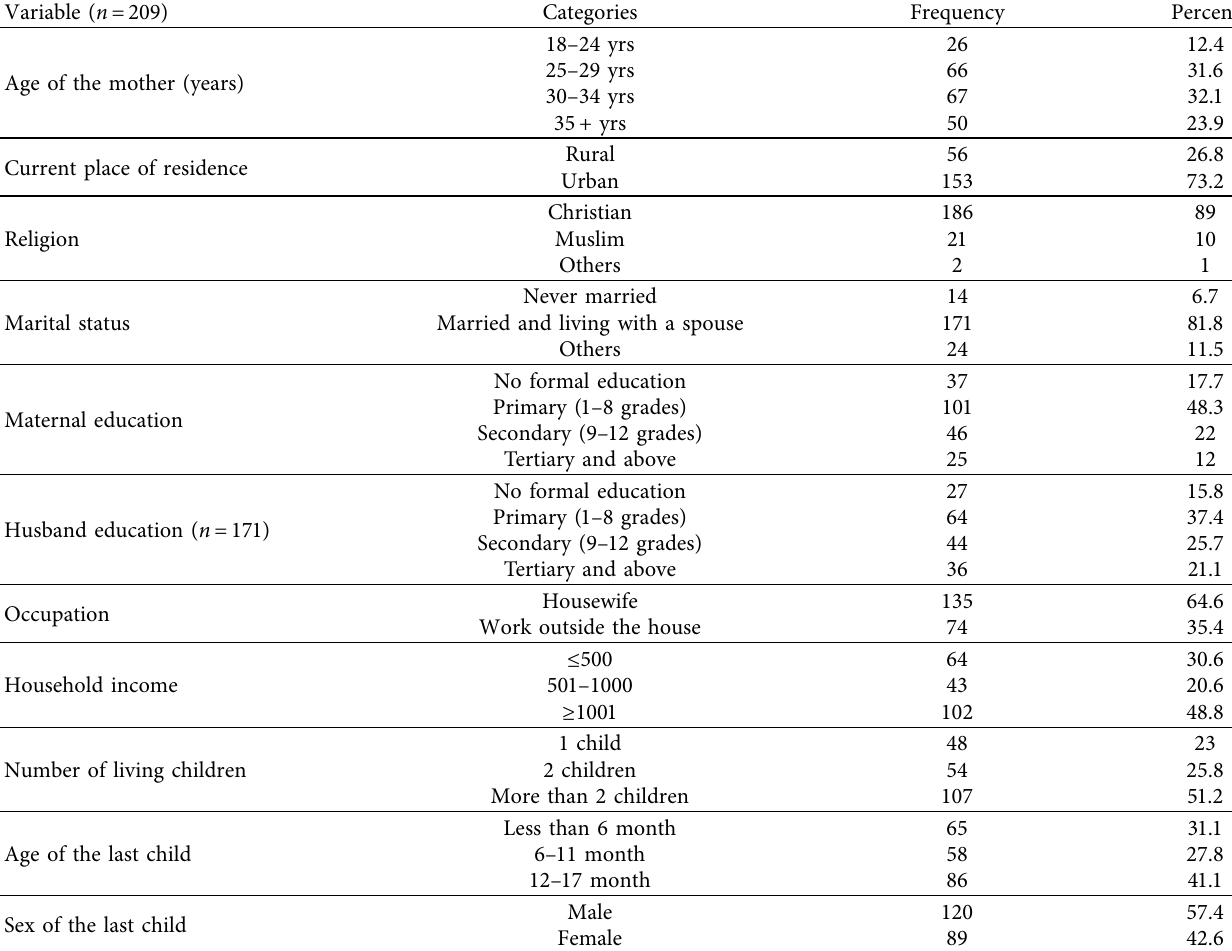
Table 1: Sociodemographic characteristics of HIV-positive mothers with a child below 18 months, SNNPR, Ethiopia, 2019. Variable ( n � 209)